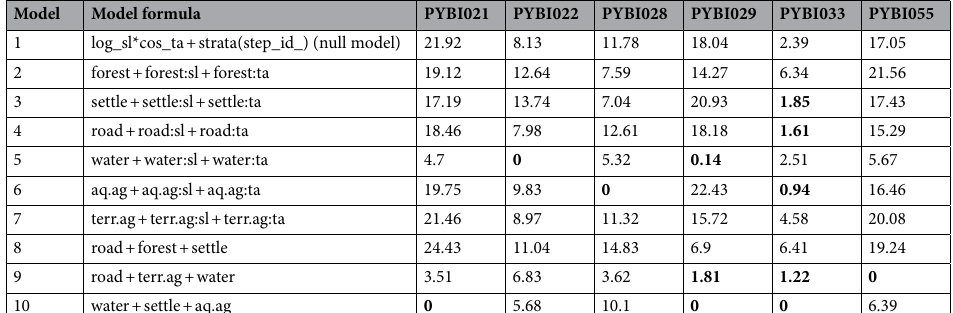
Table 2. Model formulas and (cid:31) AIC scores for individual integrated step selection functions. Integrated step selection functions were created using observed steps of radio tracked Burmese pythons ( Python bivittatus ) within the agricultural matrix (i.e., all individuals excluding PYBI060) in the Sakaerat Biosphere Reserve, Nakhon Ratchasima, Thailand. Each model includes interactive effects of turn angle and step length. sl: step length, ta: turn angle, settle: human settlement, aq.ag: aquatic agriculture, terr.ag: terrestrial agriculture. Emboldened text indicates score within < 2 Δ AIC of the model with the most support for a given